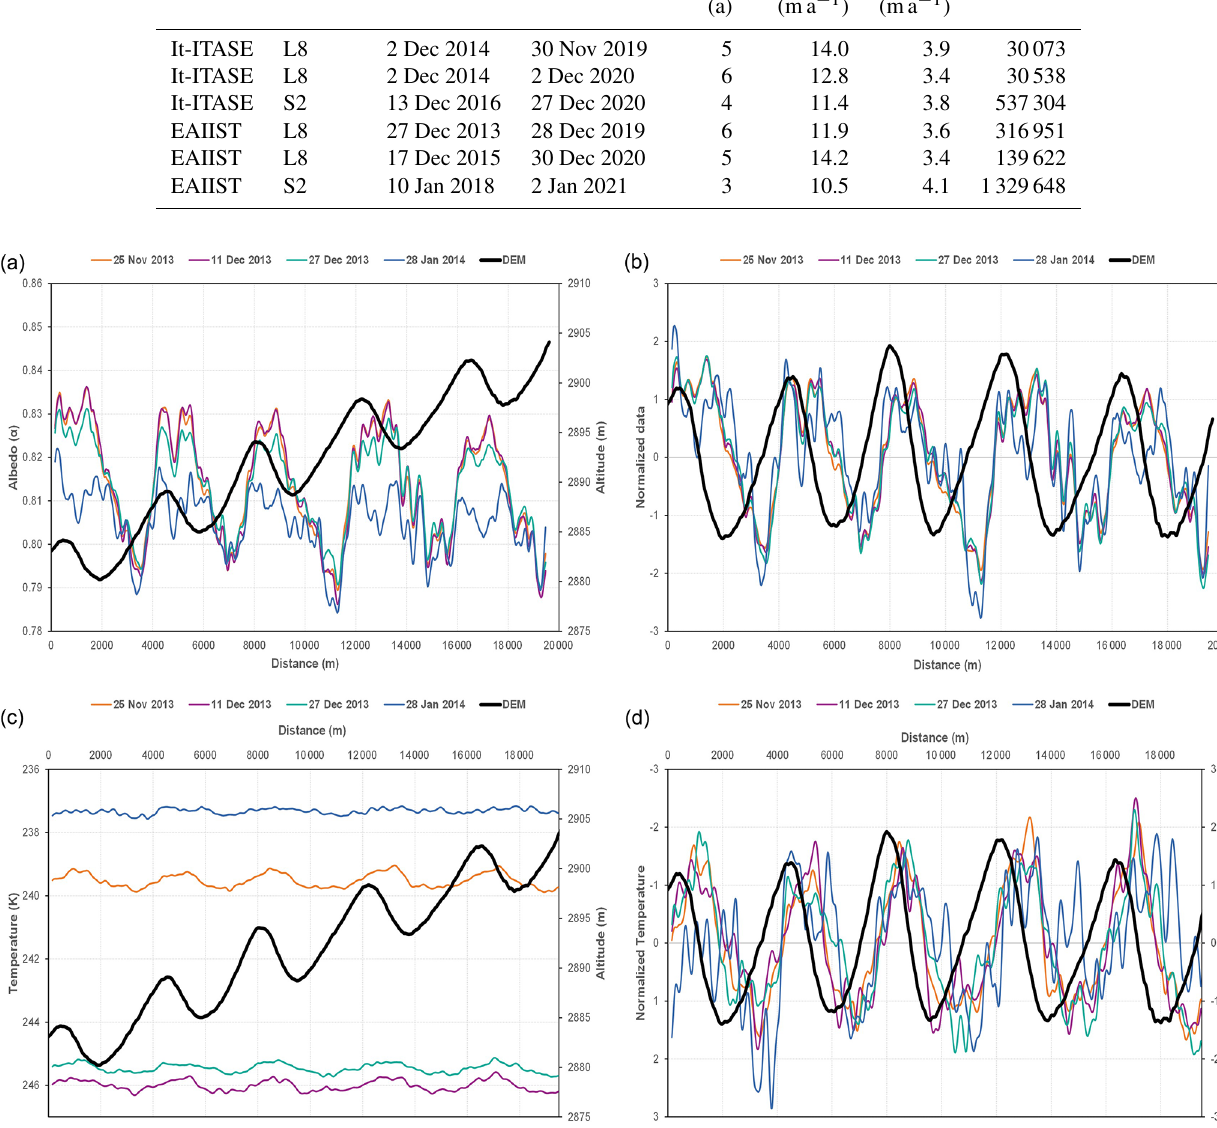
Figure 2. Moving averages (based on 11 transect pixels) of (a) NIR albedo and (c) thermal BT TIRS1 between November 2013 and Febru- ary 2014 for transect C at the EAIIST site (see Fig. 1c for location) and elevation from the REMA DEM. Corresponding normalized moving averages of (b) NIR albedo and (d) thermal BT TIRS1 during the austral summer season 2013–2014 for transect C and elevation from the REMA DEM (detrended